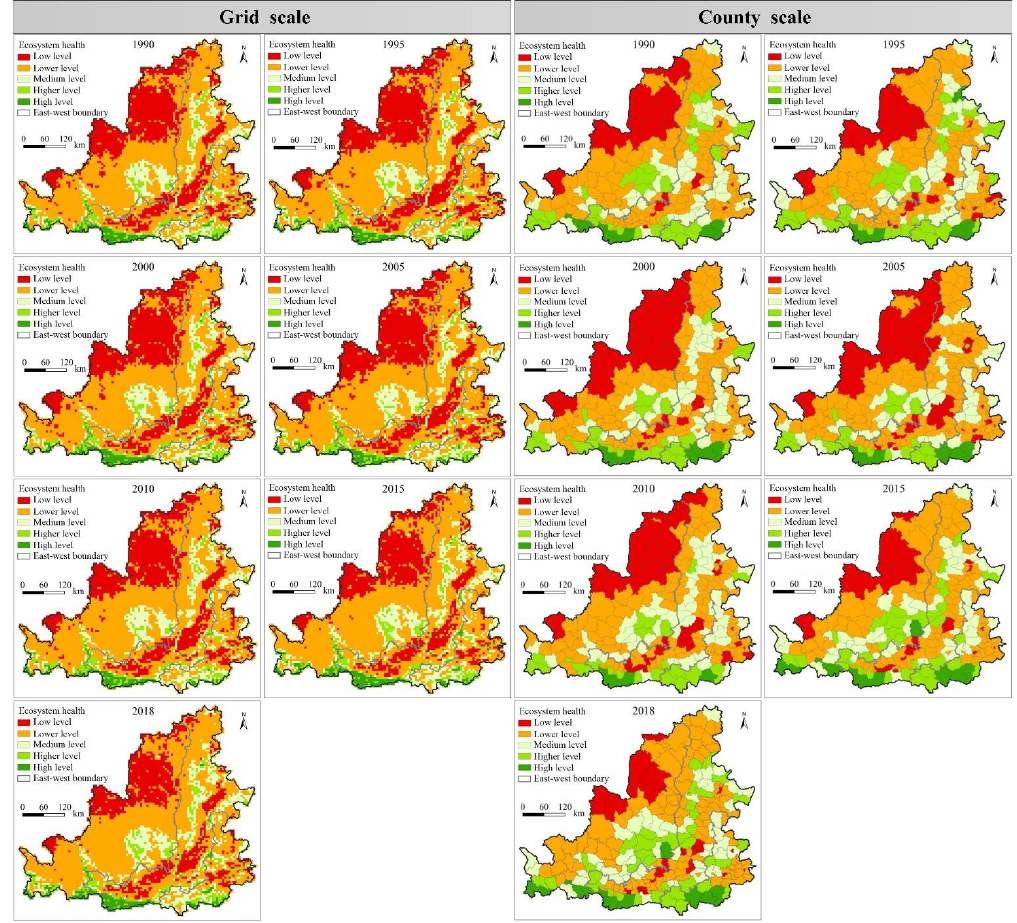
Figure 6. Spatial evolution of ecosystems health level in the MRYR from 1990 to 2018.